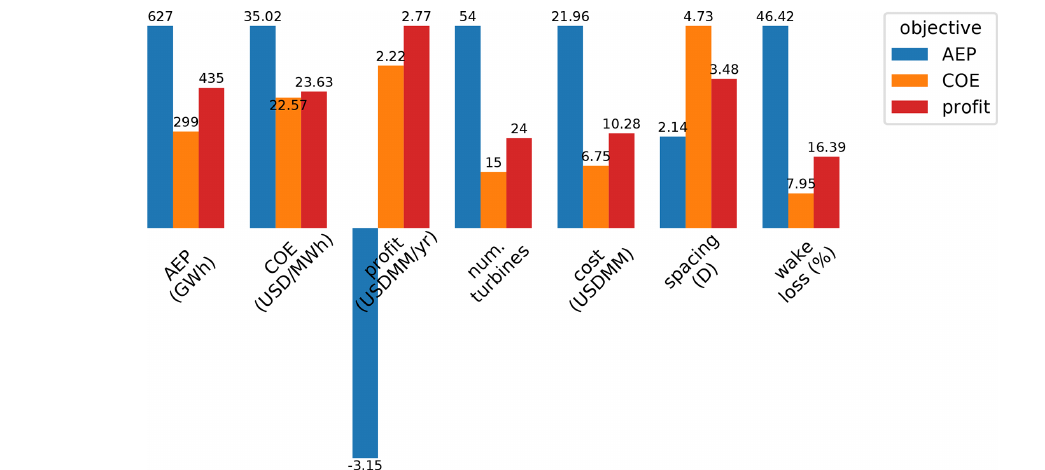
Figure 13. A comparison of the performance metrics of the three different wind power plants optimized for different objective functions. These results are shown for the large wind plant with a full wind rose.